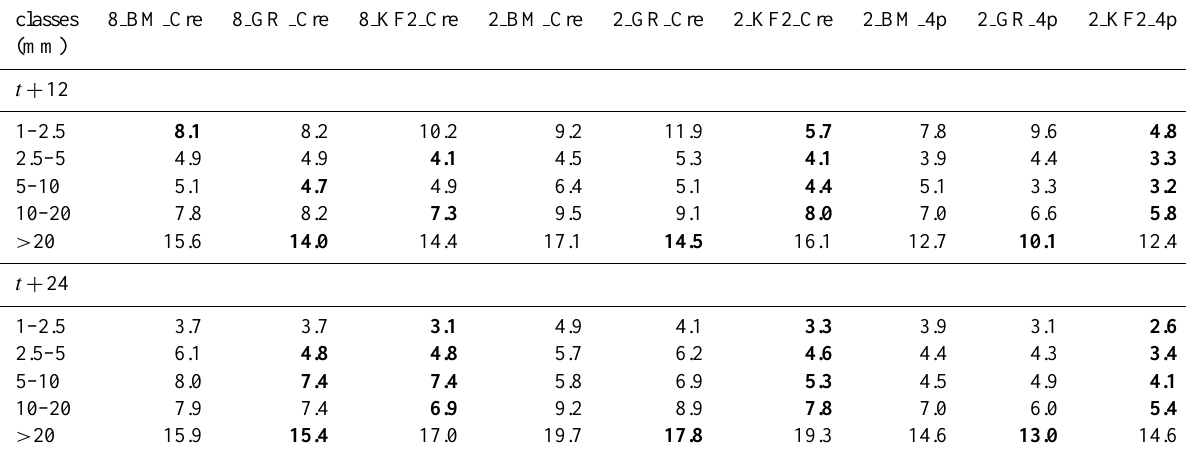
Table 6. As in Table 1 but for the three different CPSs: Betts-Miller, Grell and Kain-Fritsch-2. For each grid and for each method the best values are presented in